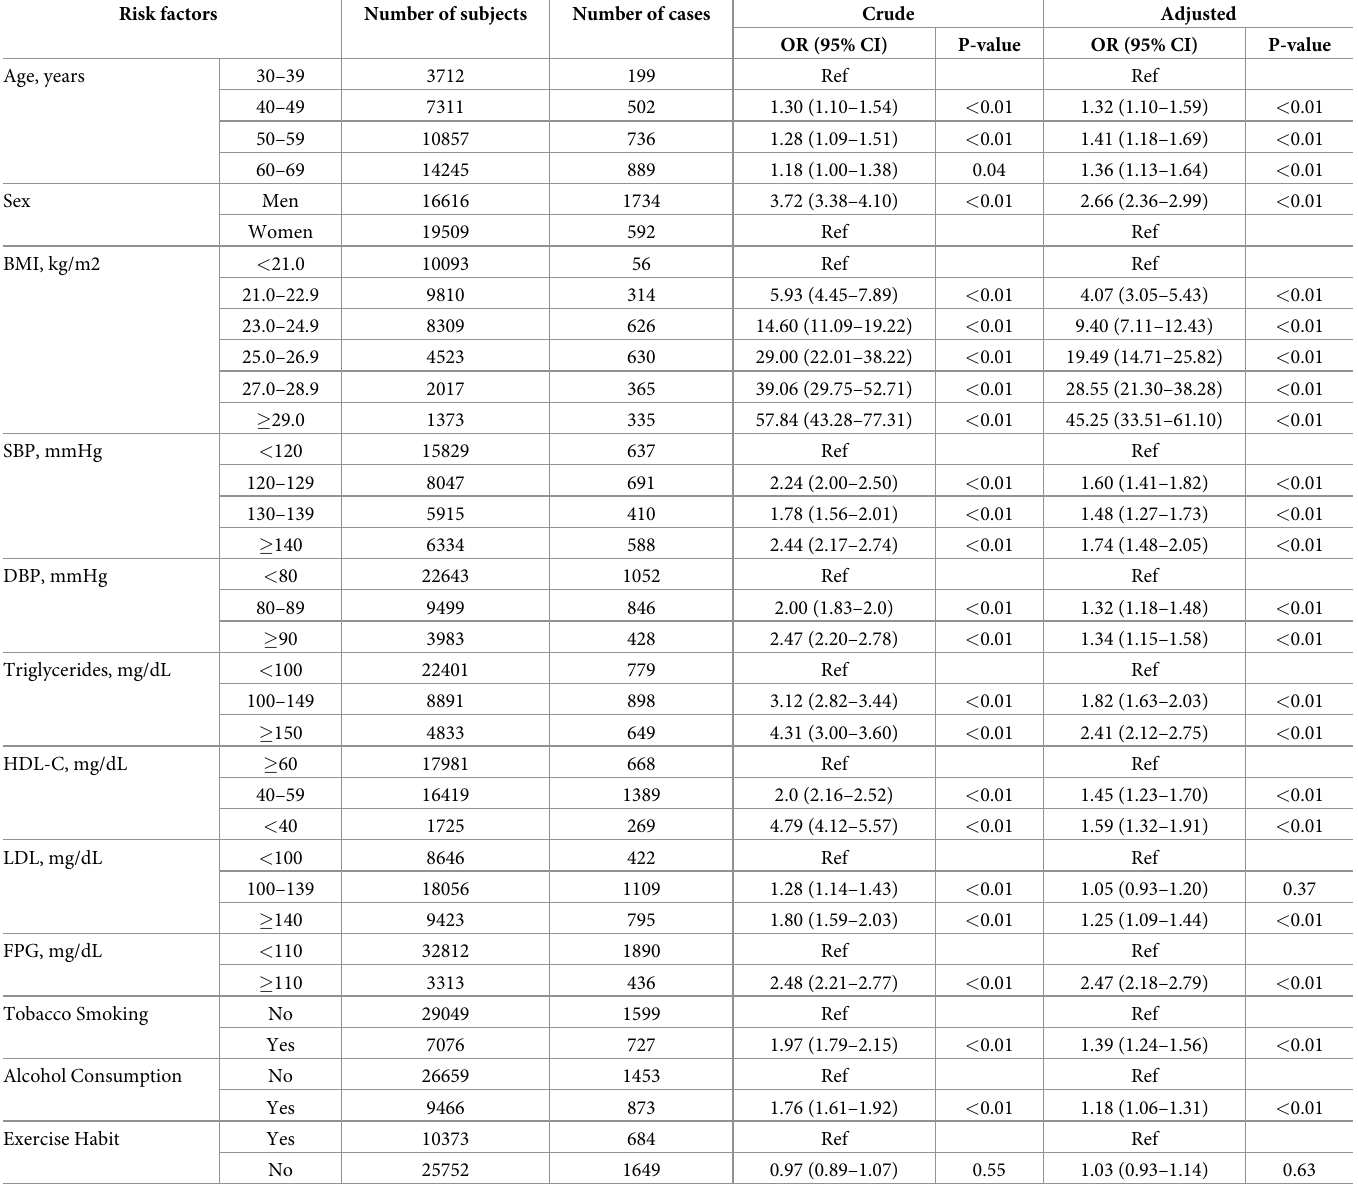
Table 2. Association between risk factor categories and 5-year metabolic syndrome